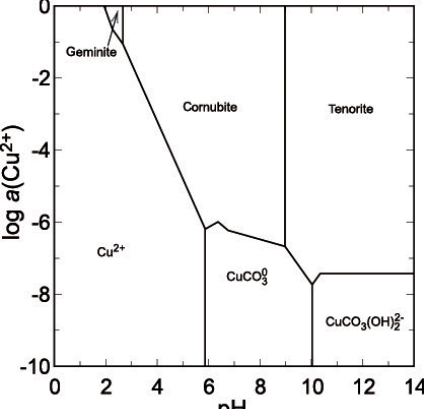
Figure 11. p ε -pH diagram of the system CuO − As 2 O 5 − H 2 O for T = 298 . 15K, log f ( CO 2 , g ) = − 2, log a( As ( V )) = − 2, olivenite is suppressed from the